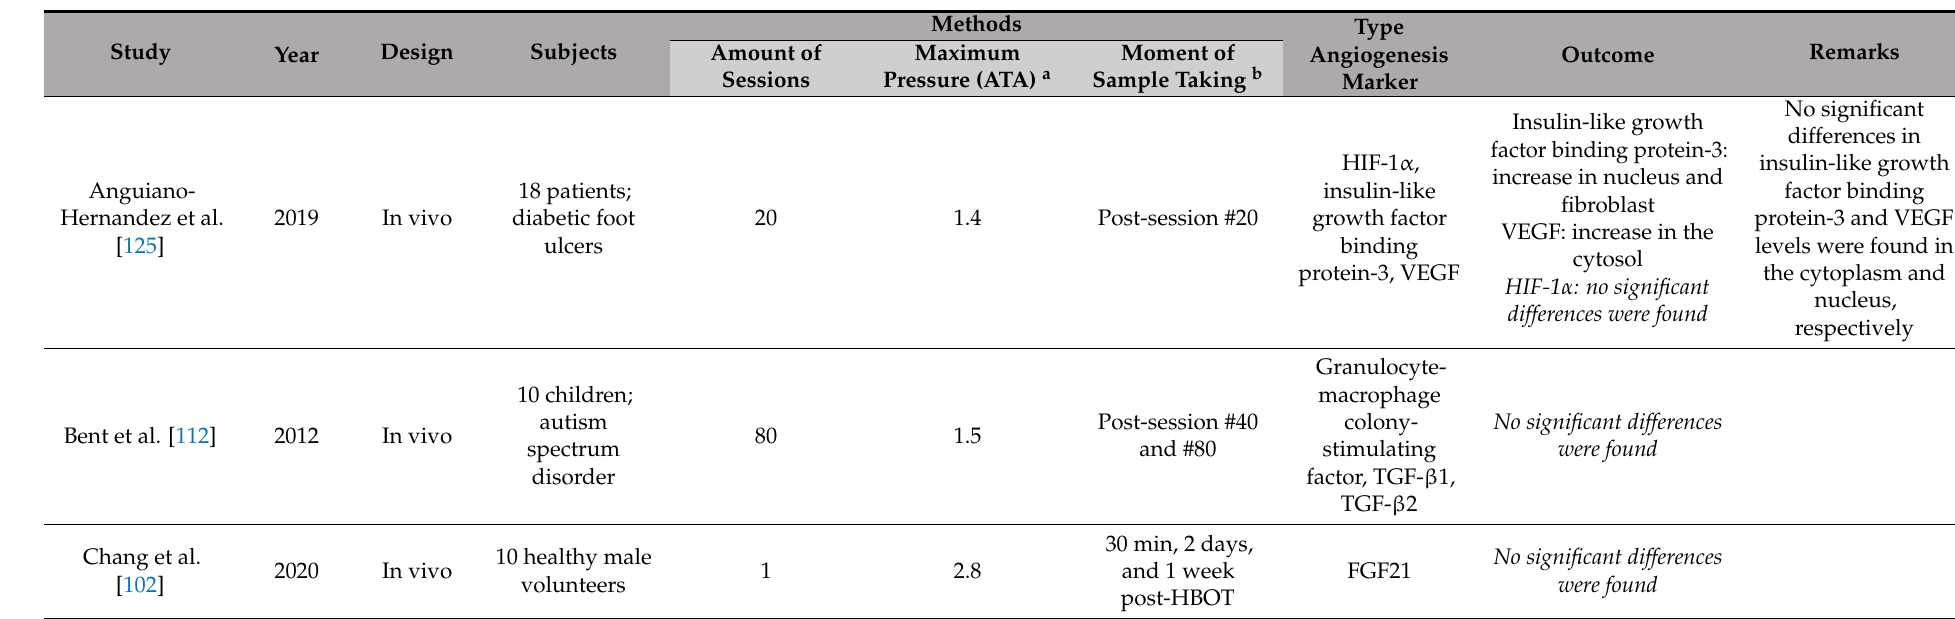
Table A5. Retrieved results on angiogenesis markers in